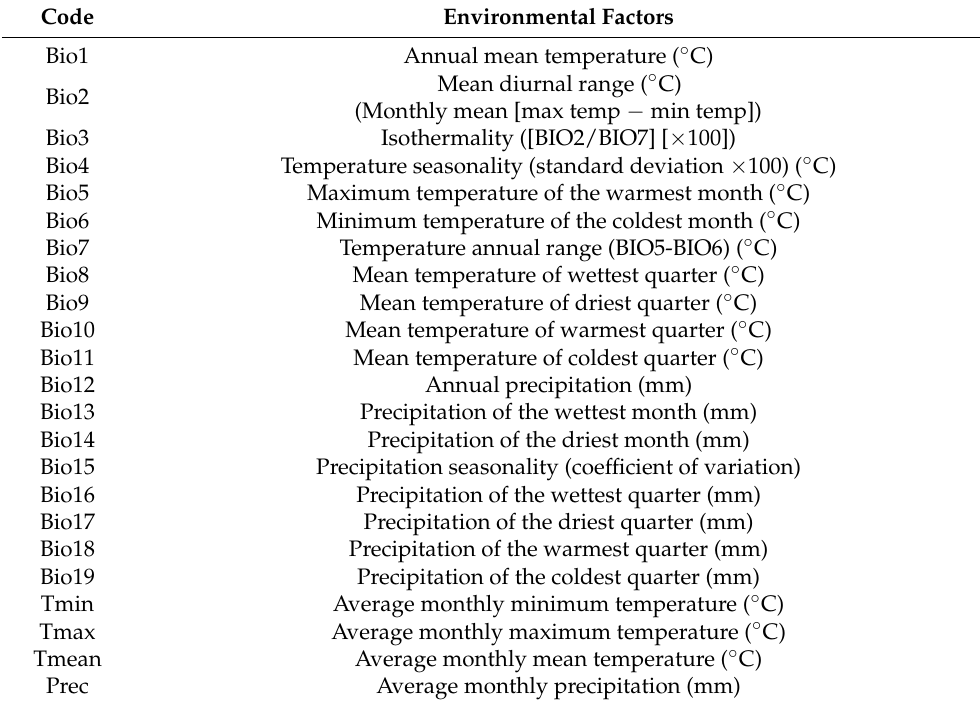
Table 1. Environmental factors for the potential geographic distribution of Mayetiola destructor